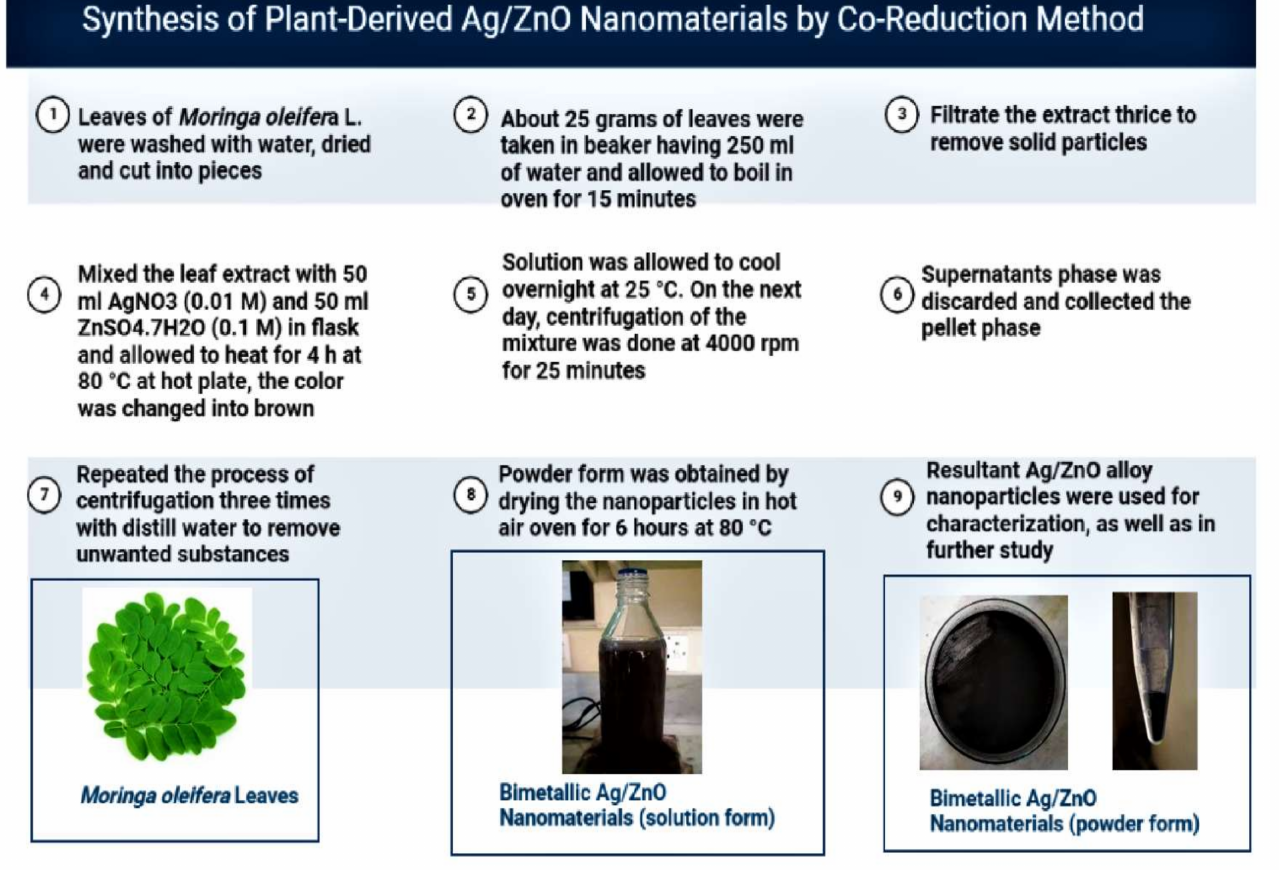
Figure 1. Method of preparation of nanomaterials. Table 1. Experimental layout of treatments (AS: ammonium sulphate, NMs: